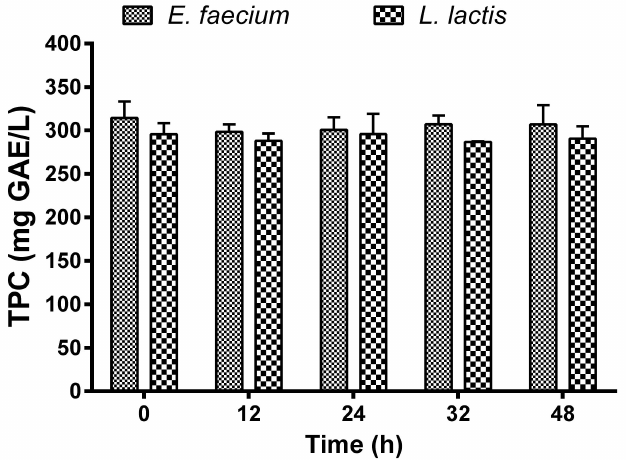
Figure 6. Total phenolic content (TPC) during the fermentation of Aloe vera extract with Enterococcus faecium and Lactococcus lactis